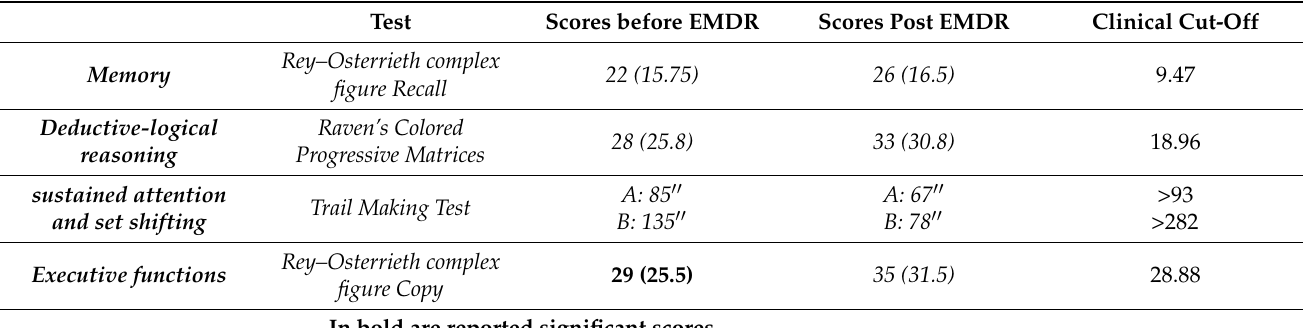
Table 2. Neuropsychological assessments before and after EMDR